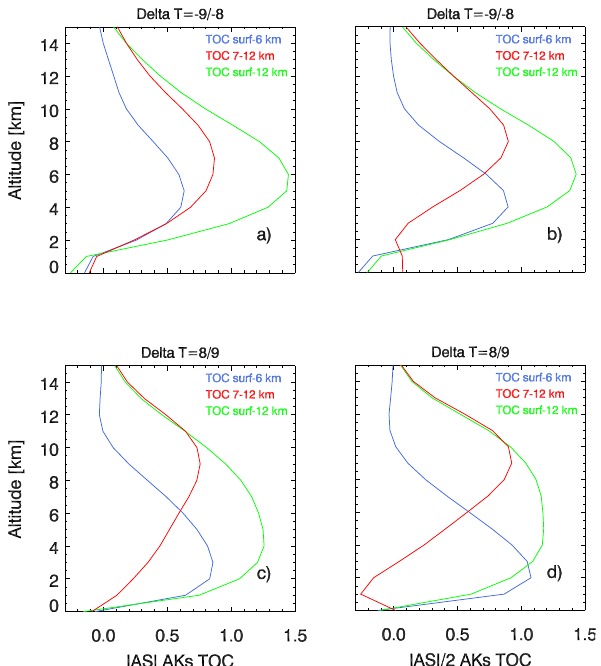
Fig. 3. Integral averaging kernel functions for the TOCs surface– 6km (blue), 7–12km (red) and surface–12km (green) for IASI: (a) low sensitivity scenario, and (c) high sensitivity scenario, and IASI/2: (b) low sensitivity scenario, and (d) high sensitivity sce- nario. The functions are means over the whole period of study (Au- gust 2009).